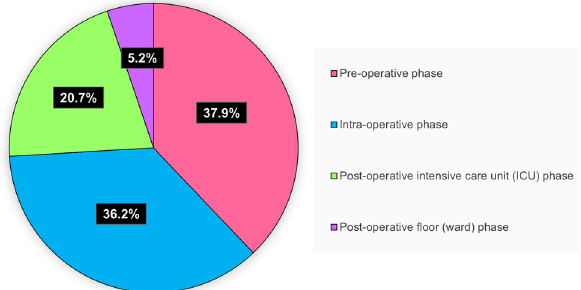
Figure 2. Phase of care mortality analysis seminal event in hospitalization phases. Using the POCMA analysis tool, the SE were categorized according to the perioperative phase of care.